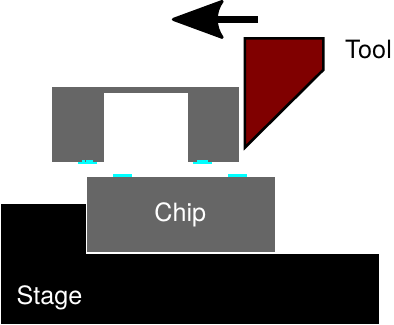
Figure 5. Schematics of the die shear strength testing